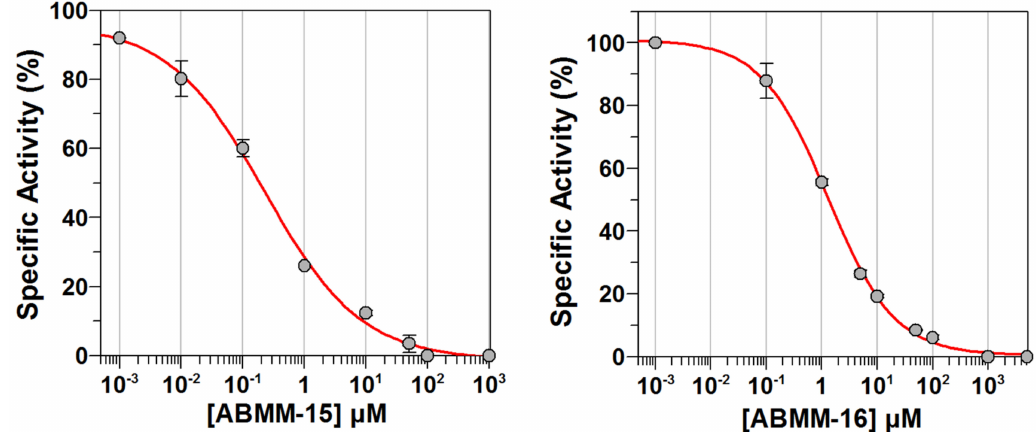
Figure 2. Representative sigmoidal curves to calculate the IC 50 values of ABMM-15 ( left ) and ABMM-16 ( right ) against ALDH1A3 at a saturating concentration of hexanal (250 µ M). The percentage of specific activity is plotted against the logarithm of inhibitor concentration. Experimental values are shown as the mean ± SE of duplicate